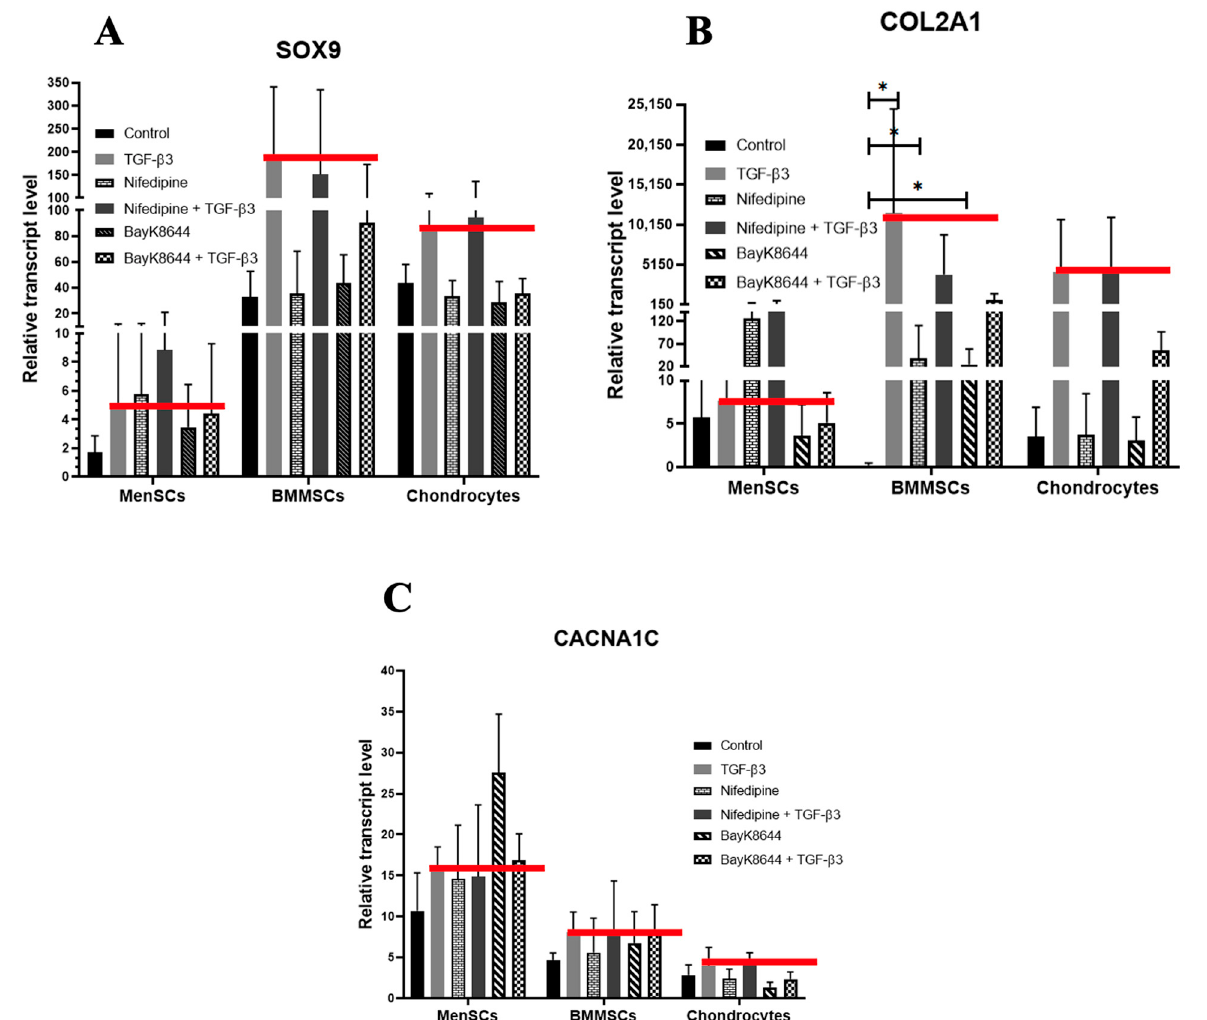
Figure 7. The effect of nifedipine and BayK8644 on chondrogenic differentiation-related genes in MenSCs, BMMSCs and chondrocytes. The expression of SOX9 ( A ), COL2A1 ( B ) and CACNA1C ( C ) after the stimulation of chondrogenic differentiation for the 21 days with TGF- β 3 (10 ng/mL), nifedipine (10 µ M) or BayK8644 (10 µ M). Control cells were cultured under the same chondrogenic differentiation conditions, but without TGF- β 3, nifedipine or BayK8644. Relative transcript level evaluated according to the housekeeping genes B2M and RPS9 . Red lines represent the gene expres- sion after the TGF- β 3 stimulation. Data are shown as mean ± standard deviation (SD) and were signi fi cant at * p ≤ 0.05.